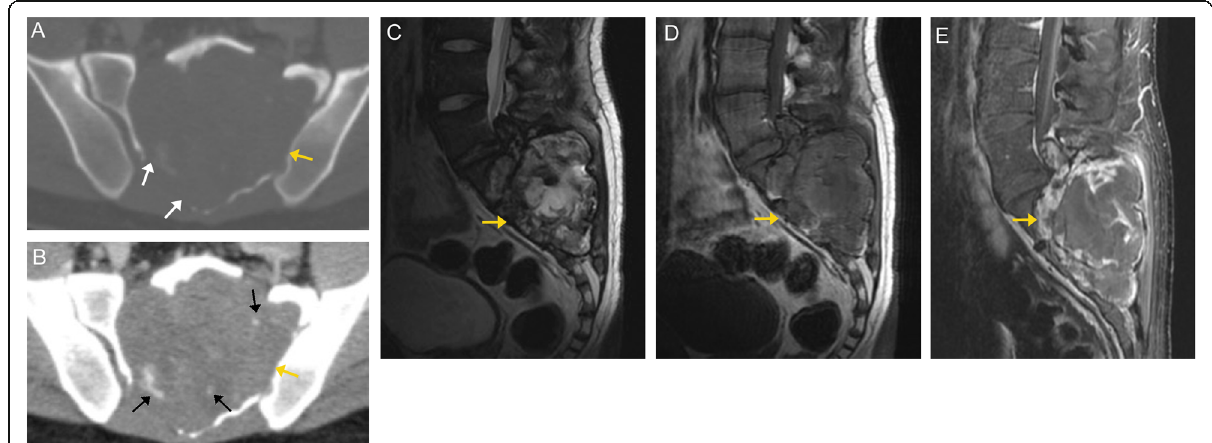
Fig. 21 Angiosarcoma. Axial CT image in the bone window ( a ) demonstrates a large lytic lesion replacing the majority of the sacrum (orange arrow), with multiple areas of cortical erosion and destruction (white arrows). In the contrast-enhanced soft tissue window ( b ), enhancing areas are present within the mass, representing serpiginous vessels (black arrows). T2 weighted MR image ( c ) of the lumbosacral spine demonstrates a heterogeneous, destructive mass within the sacrum (orange arrows), with extension into the paraspinal soft tissues. The mass is low to